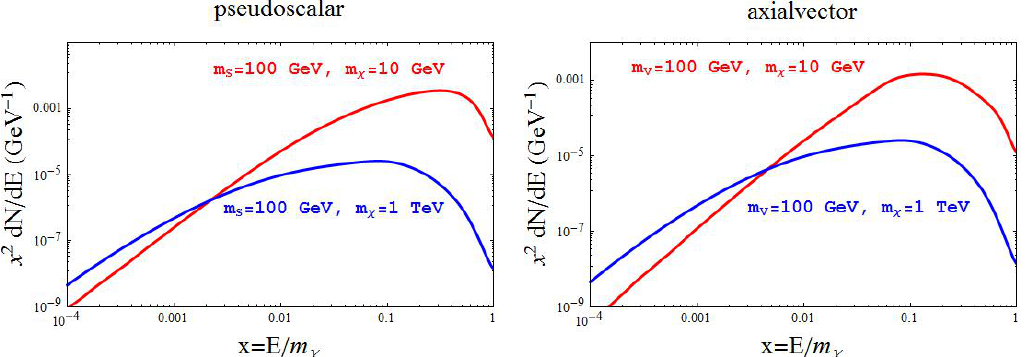
Figure 2 . Total antiproton spectrum x 2 dN i =dE as a function of x = E=m (cid:31) for the pseudoscalar mediator case (left) and the axialvector mediator case